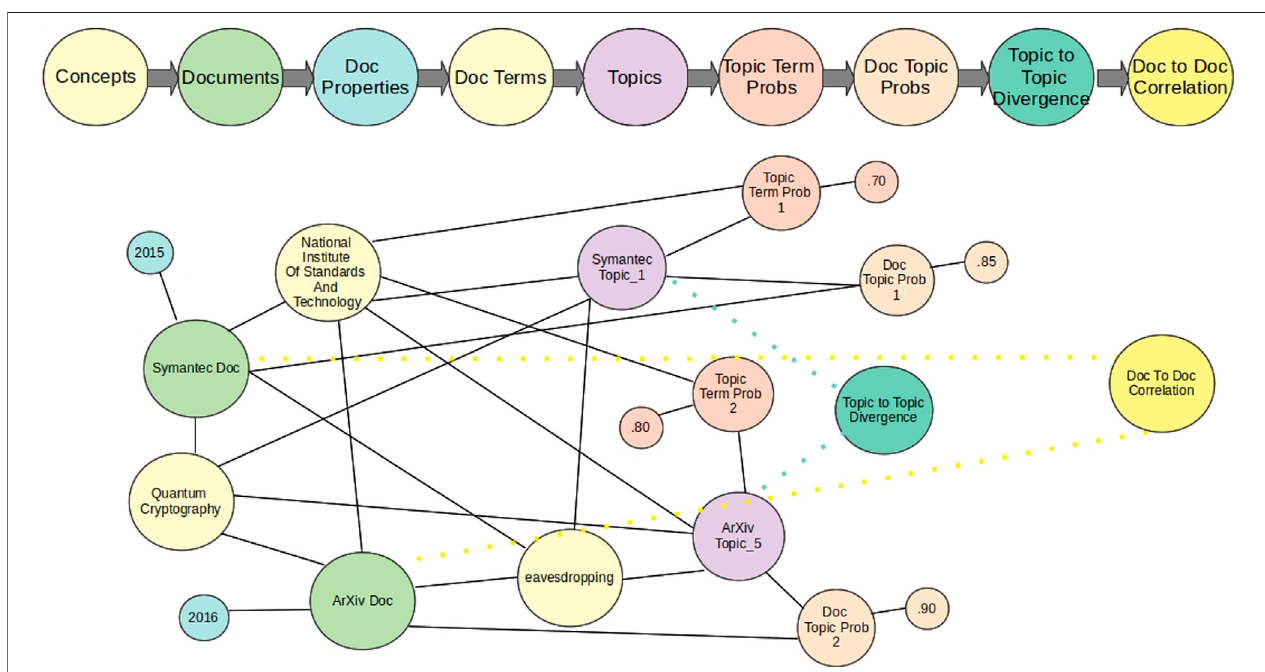
FIGURE 2 | Knowledge graph construction of the dynamic topic modeling process.